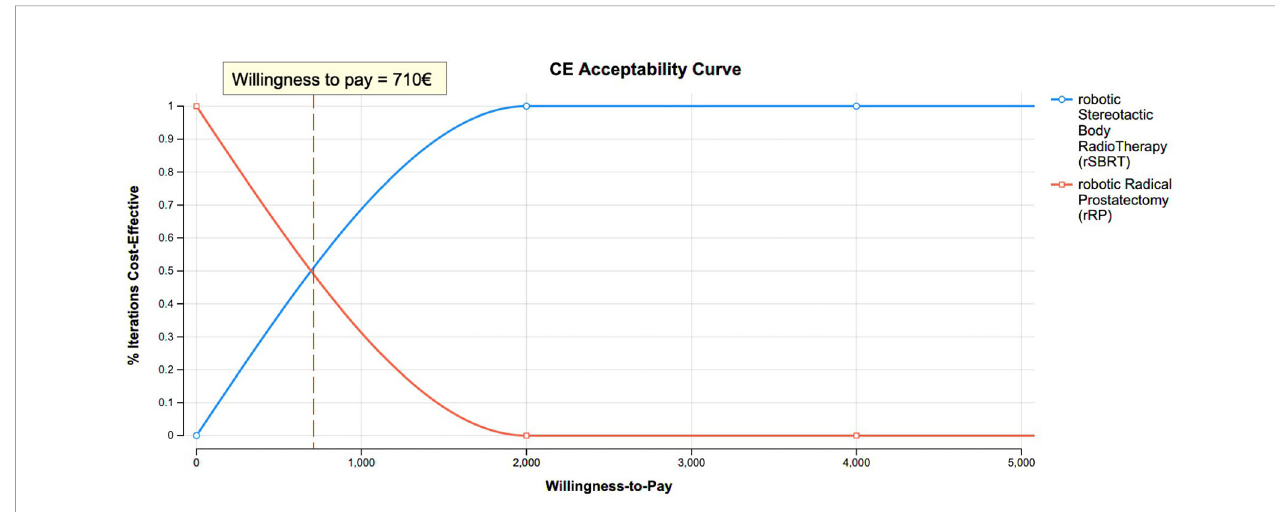
FIGURE 2 | Acceptability Curve (rRP vs